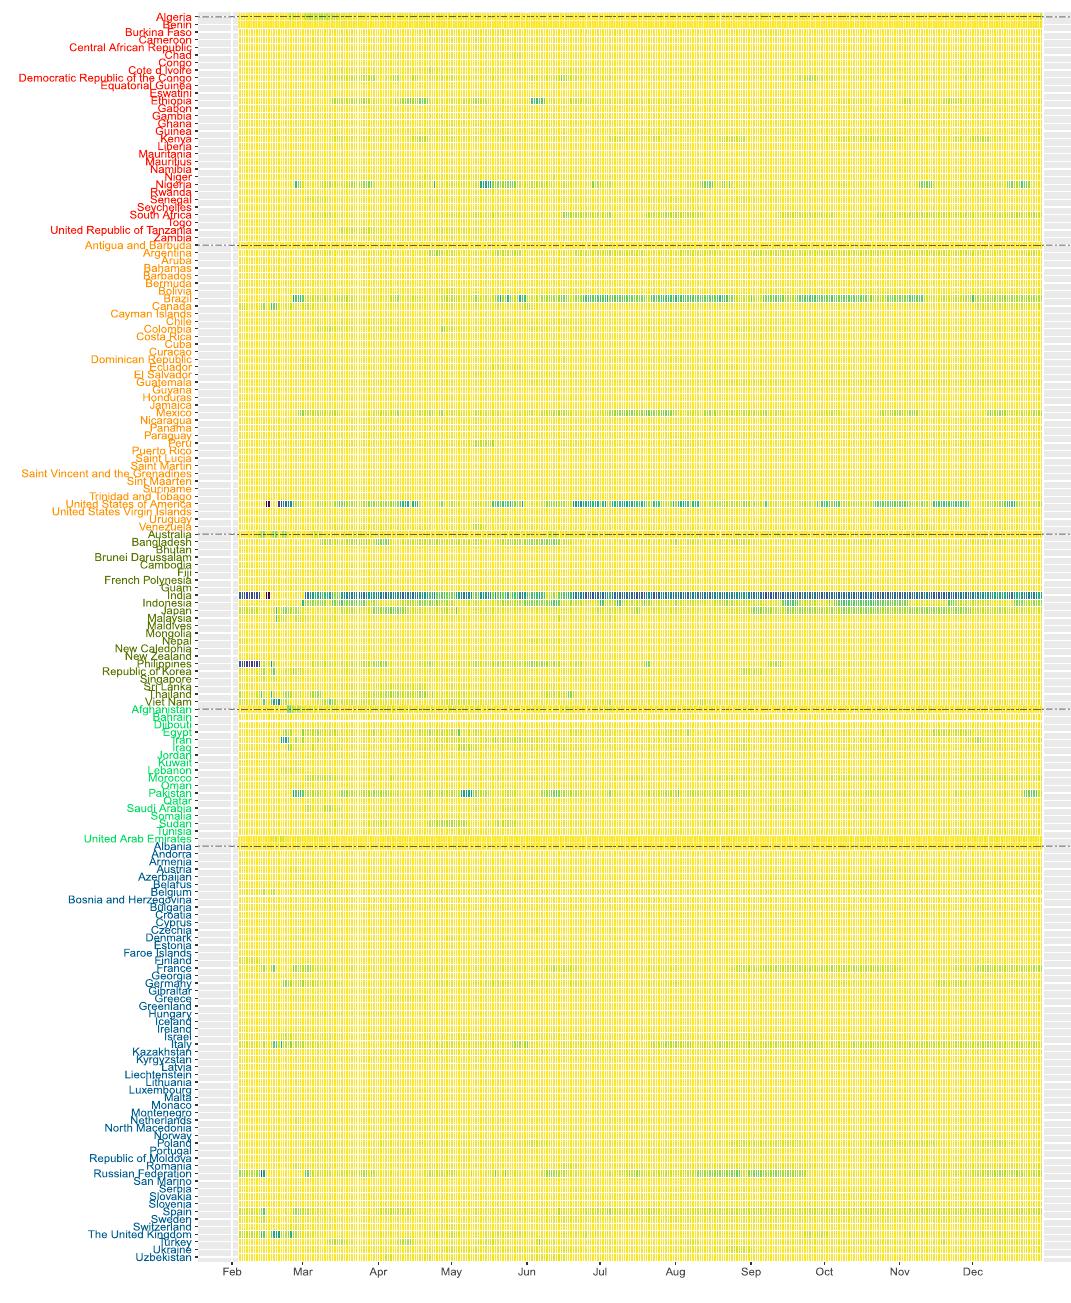
Figure 5. The heatmap of the risk contribution f it based on the preparedness risk score S 1 t for the 164 countries from February to December